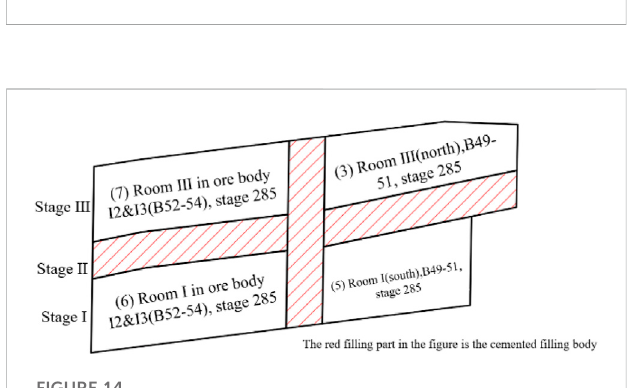
FIGURE 13 Continuous mining plane diagram.